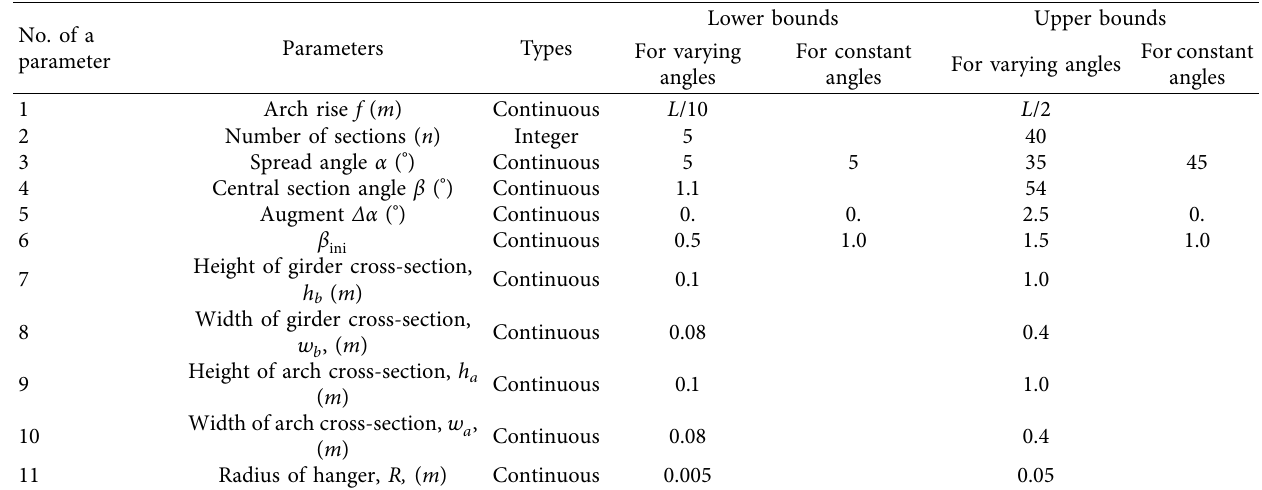
Figure 1: Bridge scheme with the main design parameters. Table 1: Set of design